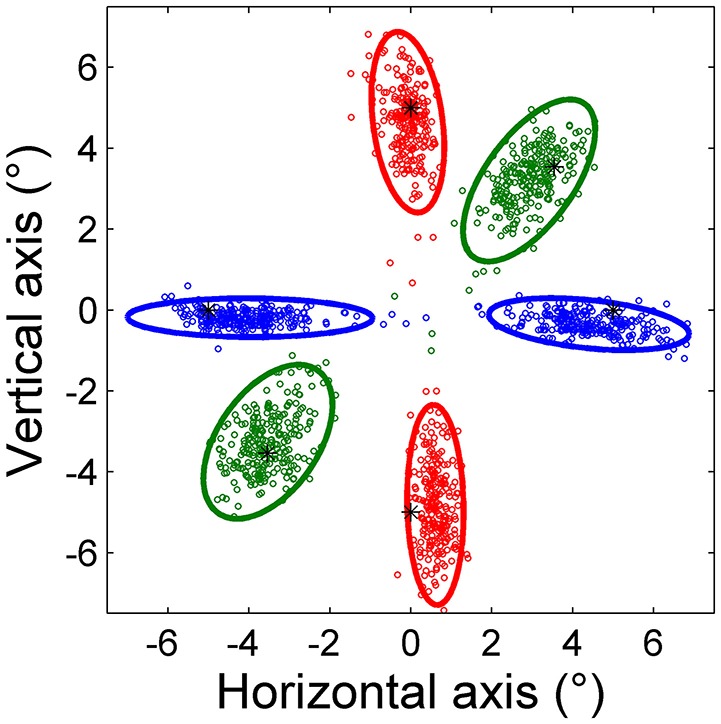
Saccade endpoints of horizontal (blue), vertical (red), and oblique (green) predictive saccades made by a representative subject during Task H, Task V, and Task O, respectively. All saccades were toward a point target, represented by an asterisk (*). The 95% confidence ellipses are shown.